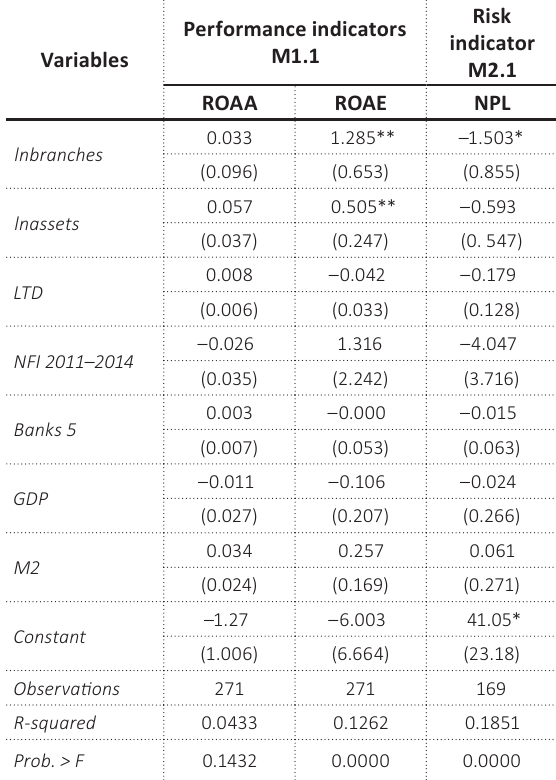
Table 4. OLS estimation results for M1.1 and M2.1